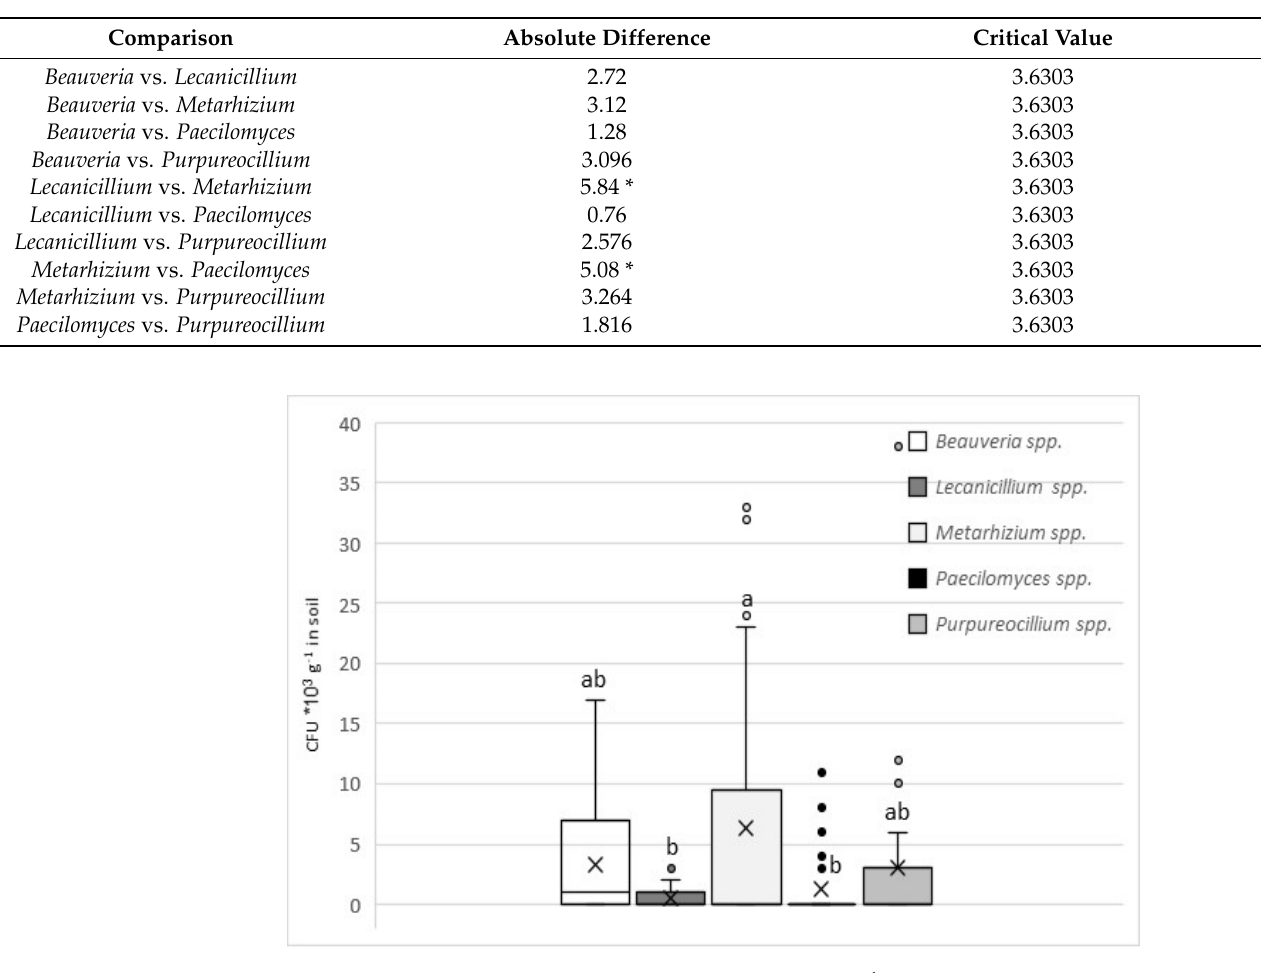
Figure 1. The amount of colony-forming units (CFU g − 1 ) in soil, considering species of ento- mopathogenic fungi found. Letters above the bars indicate significant differences between treatments at p < 0.05 when compared using Tukey’s test (x-mean; box 25% and 75% quartile; whiskers-minimum and maximum).